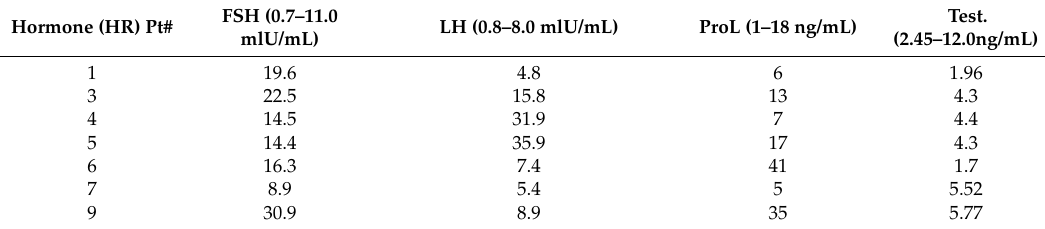
Table 1. Hormone levels in blood of SCOS patients. The levels of follicle stimulating hormone (FSH), luteinizing hormone (LH), prolactin (Prolac), and testosterone (T) were examined in the blood of SCOS patients without sperm by